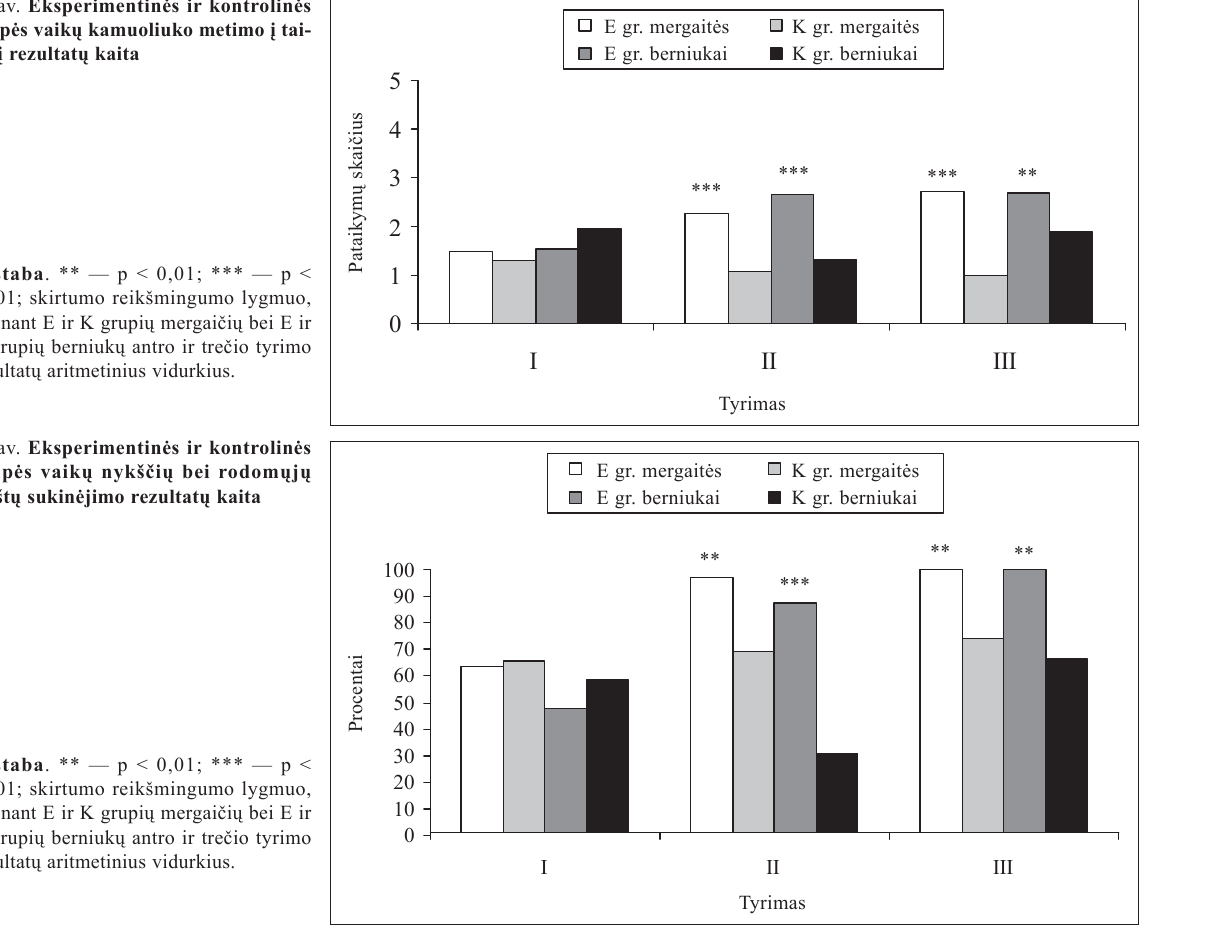
naš ū s. Rezultat ų aritmetiniai vidurkiai